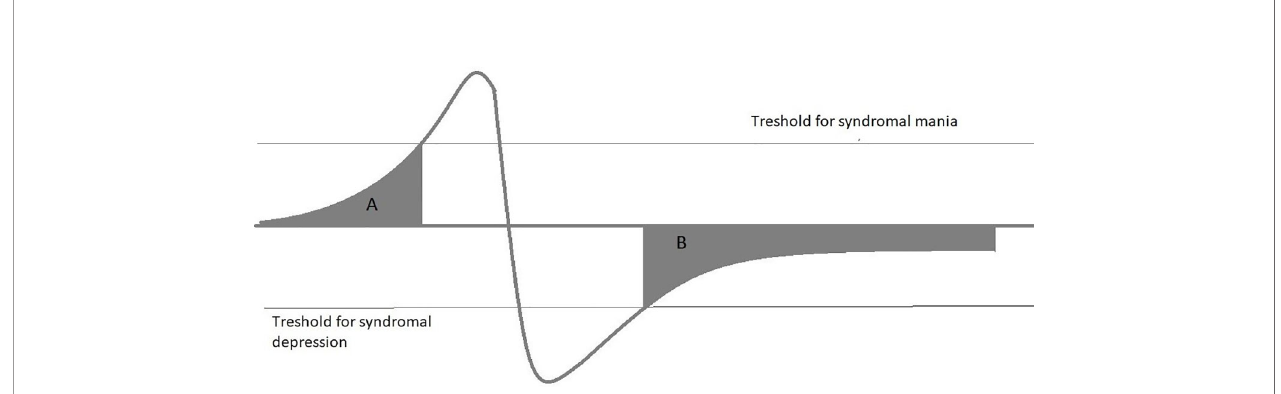
FIGURE 2 | Subsyndromal symptoms in BD may occur as integral part of some bipolar spectrum disorders, e.g., cyclothymia, where mood swings do not ful fi l full syndromal criteria, as precursors of a full-blown episode (A) or as residual symptoms after either a manic or depressive episode, sometimes with chronicity (B) .